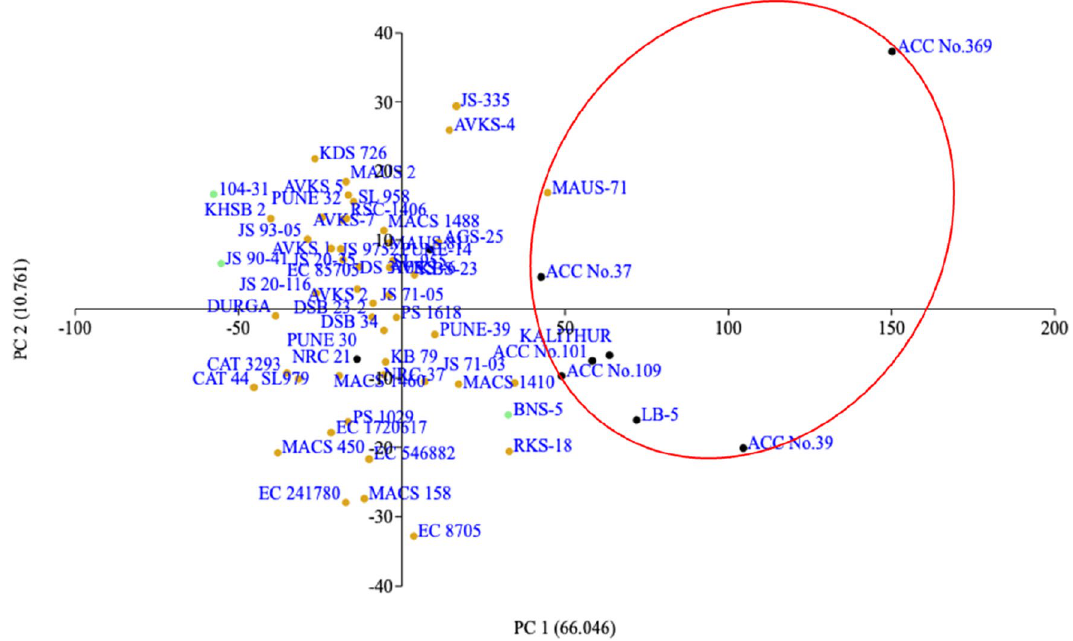
Figure 3. Scatter plot of soybean genotypes based on PC1 and PC2 (Black, Green, and Yellow colour dots indicate Black, Green, and Yellow seed coat colour